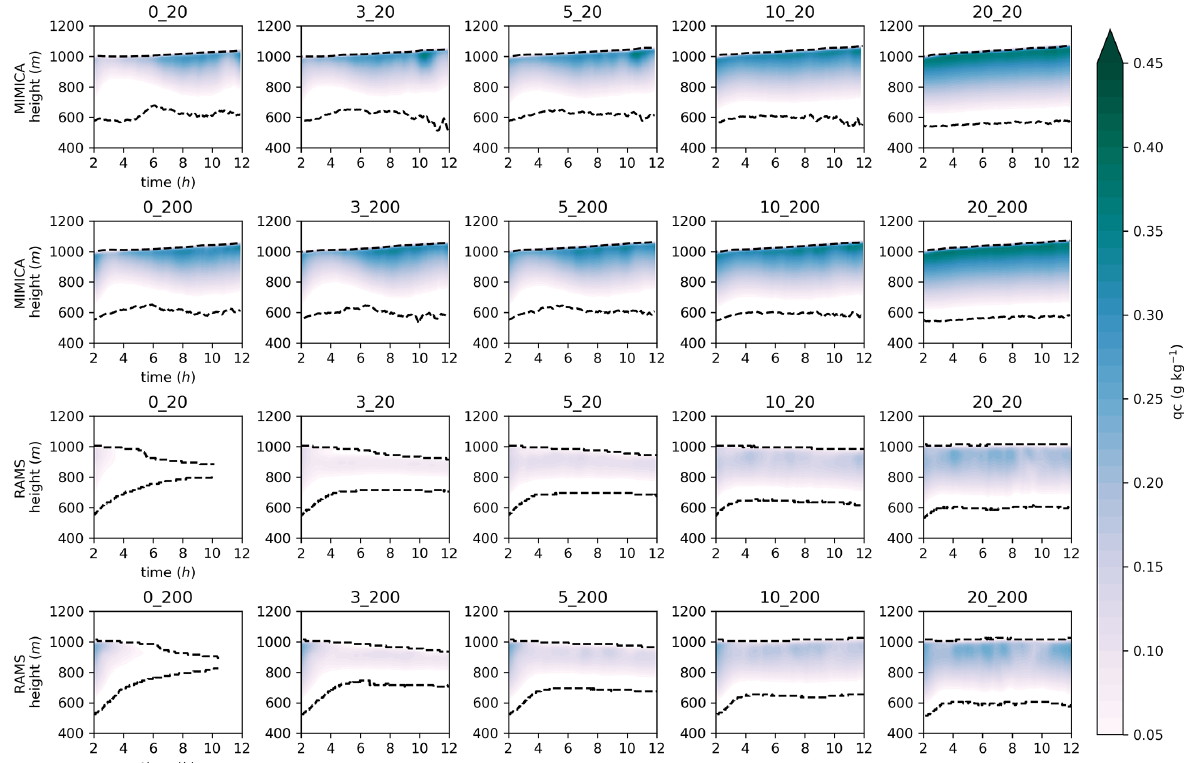
Figure 5. Cloud droplet mixing ratio (qc) for the MIMICA and RAMS simulation sets. The first 2h of simulations, considered as the spin-up period, are excluded. For figure clarity, the plot titles have been abbreviated; the first number refers to the accumulation mode and the second to the Aitken mode concentration in cubic centimetres, i.e. 0_20 refers to AC0_AK20. Black dashed lines represent the cloud top and cloud base heights.